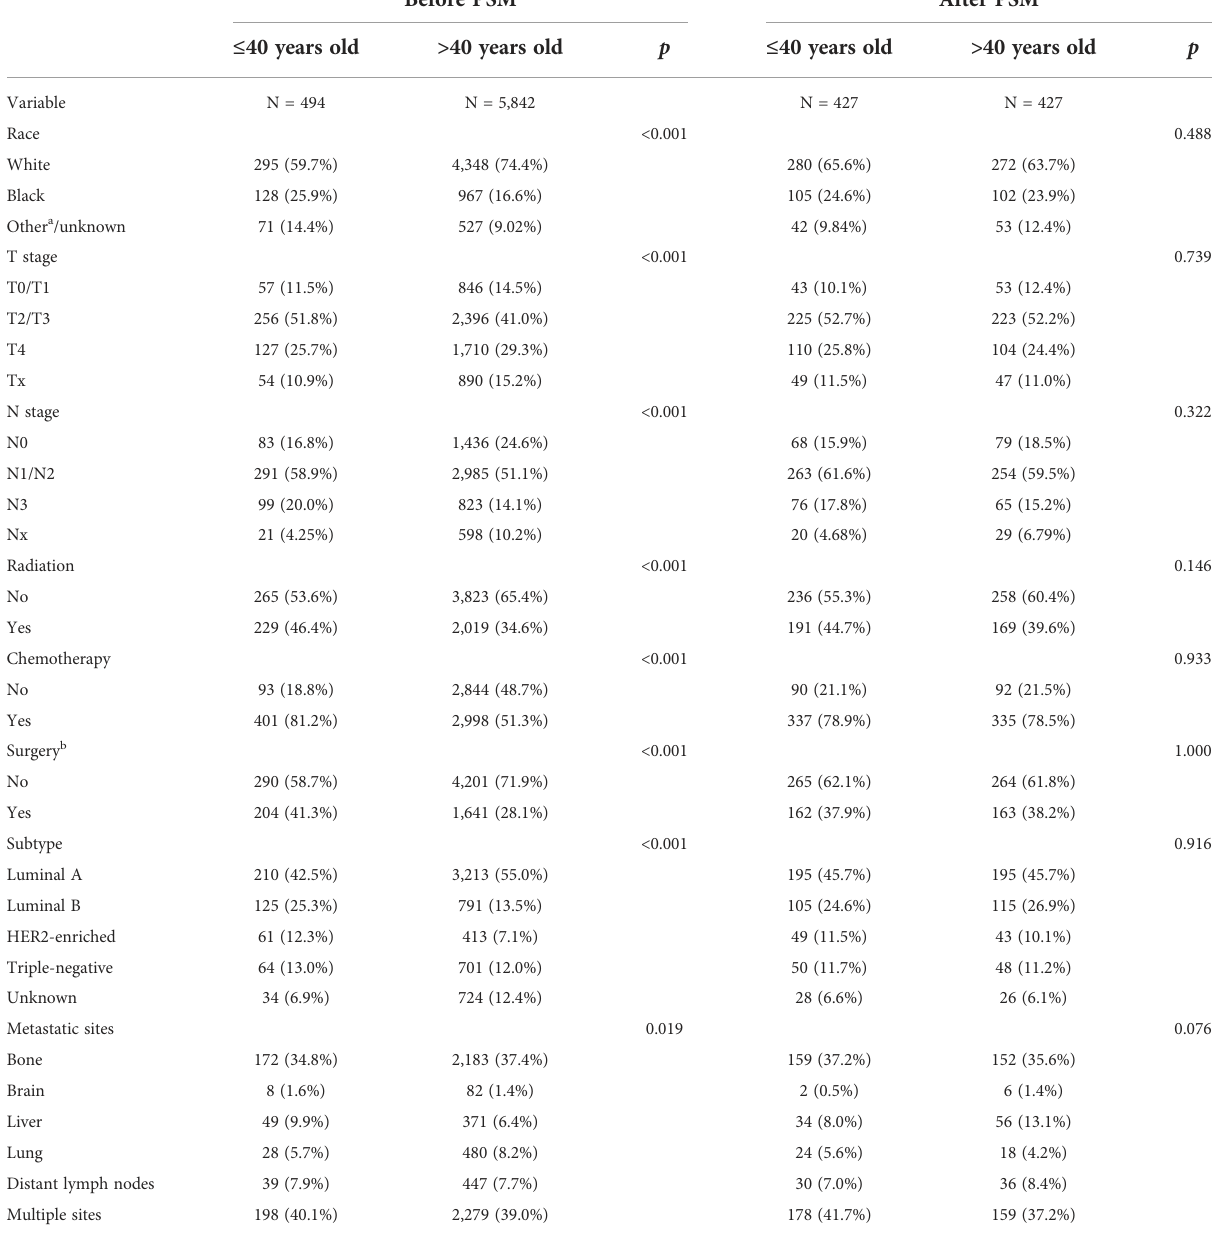
TABLE 1 Comparison of the clinical and pathological characteristics between two age groups before and after PSM. Before PSM After PSM ≤ 40 years old >40 years old p ≤ 40 years old >40 years